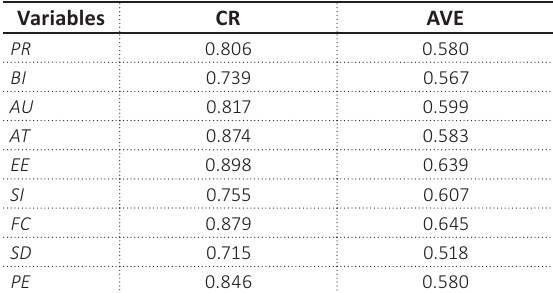
Table 2. Reliability and validity statistics –